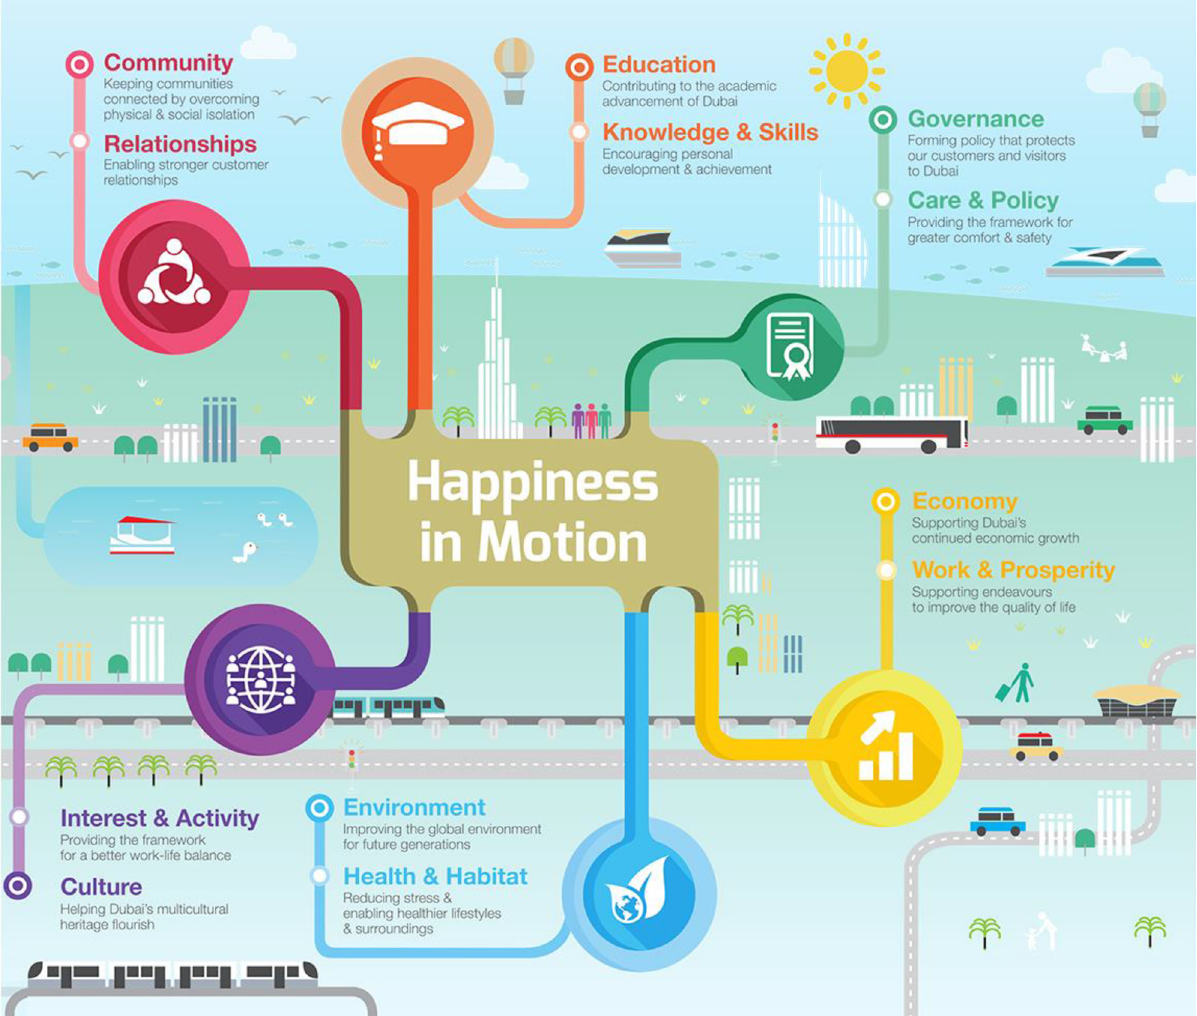
Fig. 7. Dubai plans for happiest city on Earth